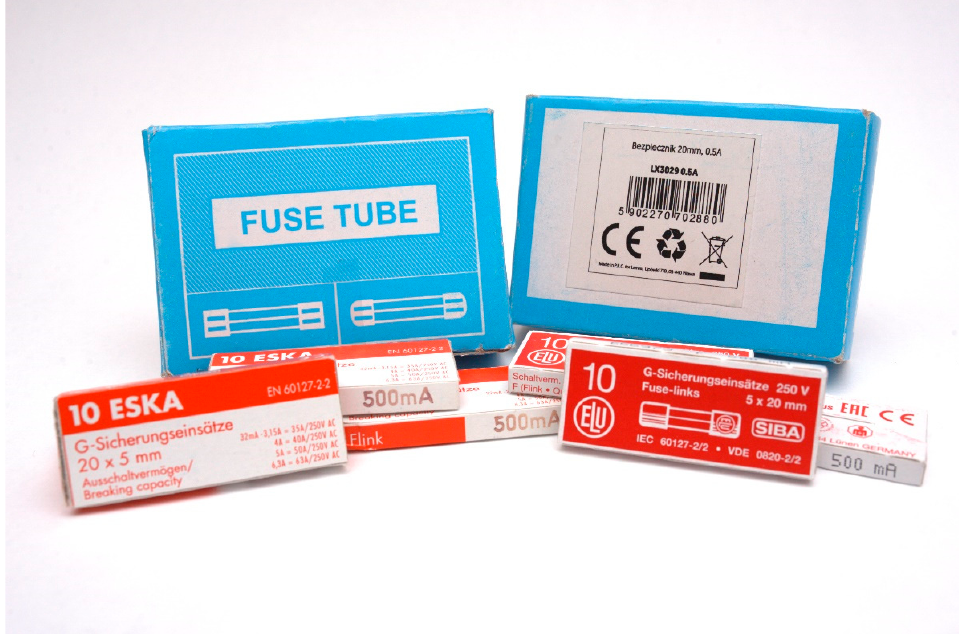
Figure 2. Cross-section of the miniature fuse-links without a quenching medium used during the experiments.